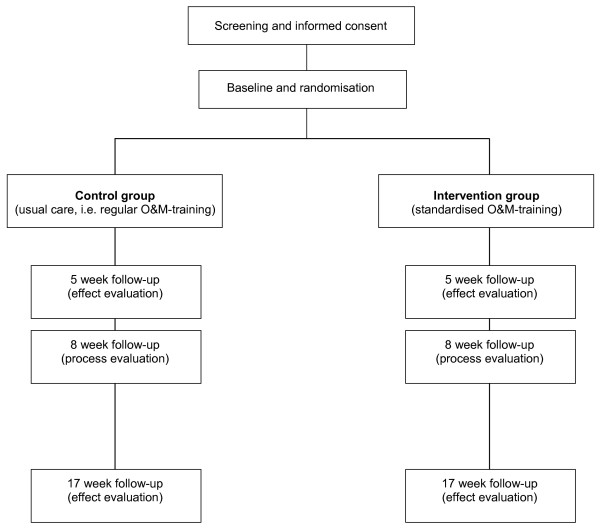
Design of the trial.